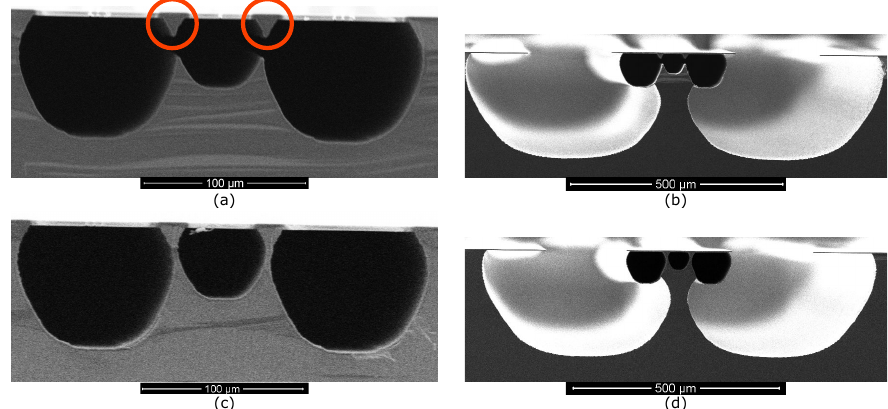
Figure 7. SEM photographs show the cross-sectional views of the fabricated test structures using three microchannels with the big-small-big channel configuration. In ( a , b ) two silicon electrodes with triangular cross-sections are highlighted in the red circles. In ( c , d ) no silicon electrodes are